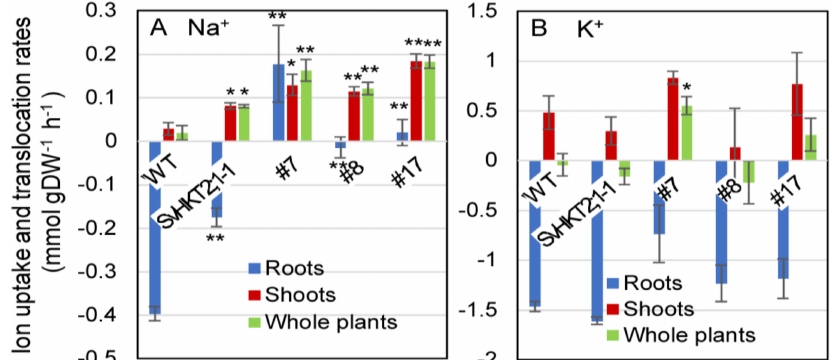
Figure 9. Na + and K + uptake and translocation rates in SvHKT1;1 transgenic lines and WT plants under salt stress. Twelve-day-old Arabidopsis seedlings, which were pre-incubated in 1 / 2 MS liquid medium for 24 h to adapt to liquid medium, were transferred into micro cuvettes filled with 1 / 2 MS liquid medium supplemented with 100 mM NaCl and further incubated for one hour. Their roots and shoots were separately harvested before and after the treatment, dried overnight, and